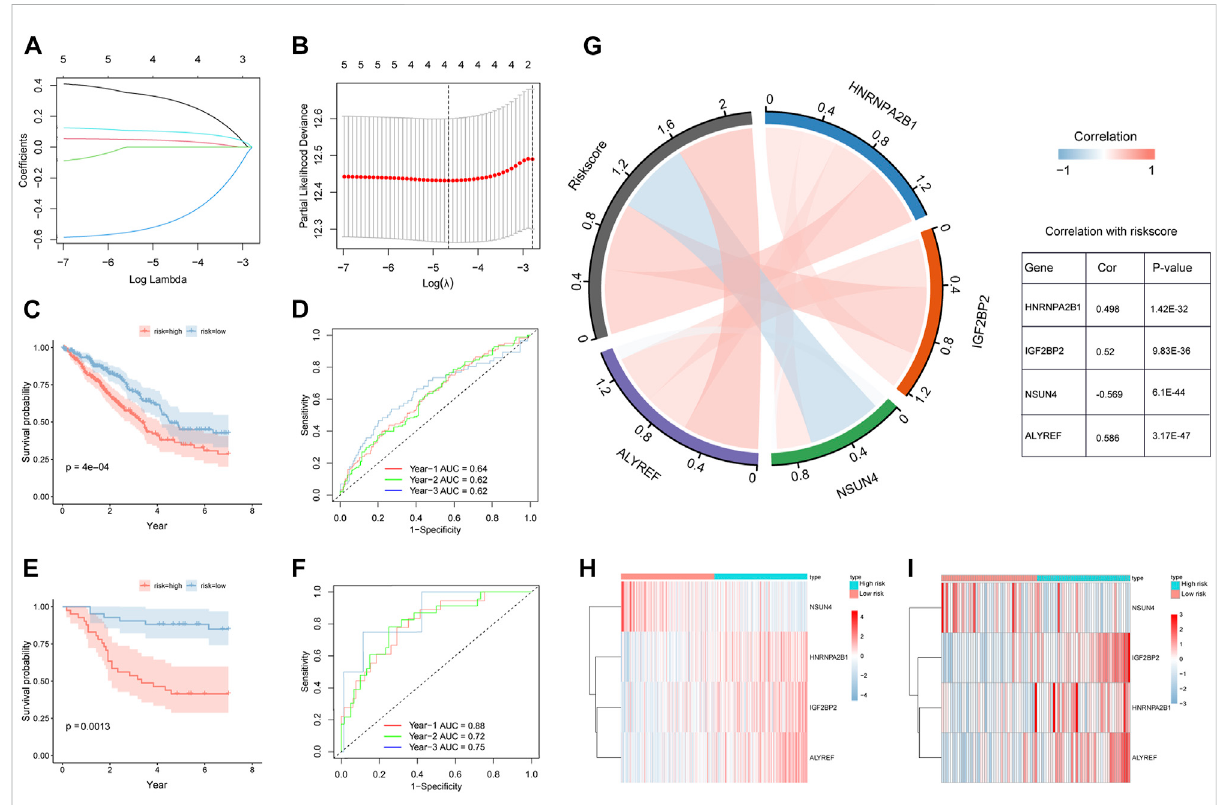
FIGURE 5 Construction and validation of m5C/m6A regulator-related prognostic model. (A,B) LASSO-Cox regression model by 10-fold cross-validation for OS in LUAD. (C) KM curves for the OS of high-risk and low-risk groups in TCGA training set. (D) Time ROC for OS in TCGA training set. (E) KM curves for the OS of high- and low-risk groups in the GEO testing set. (F) Time ROC for OS in the GEO training set. (G) Correlation chord plot of